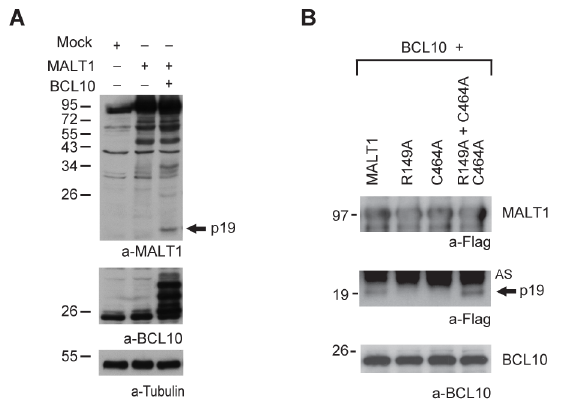
Figure 2. BCL10 mediates cleavage of MALT1 at R149 in 293T cells. A) Immunoblot of lysates of 293T cells transiently expressing MALT1 alone or in combination with BCL10 with antibodies against MALT1 [31], BCL10 and tubulin. B) Immunoblot of streptavidin pull- downs (bio-IPs) of Avi-tagged MALT1 and its mutants co-expressed with BCL10 in 293T cells as specified. AS: a-specific band. Arrows indicate the N-terminal p19 cleavage fragment. All molecular mass standards are in kDa.